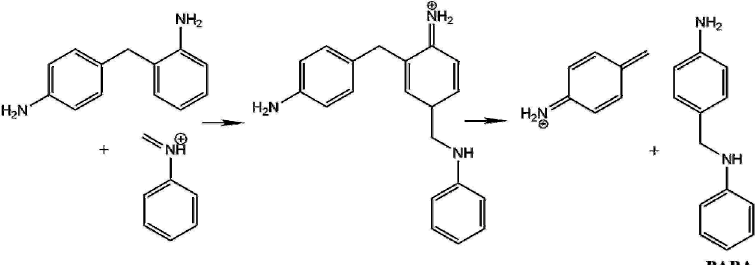
Figure 5. Schematic reaction mechanism of the formation of the 3-ring adduct and its dissociation to N-methylenebenzeneaminium and PABA.